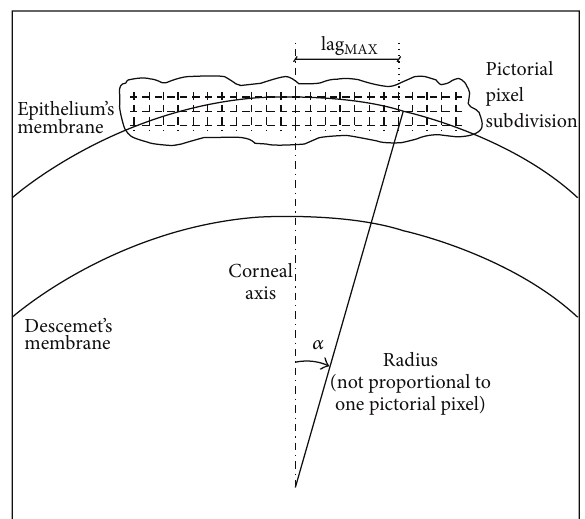
Figure 3: Pictorial representation of the procedure used to estimate the maximum number of columns on which the pixel intensity analysis is performed. In this sketch, the drawn Radius is not proportional to the pictorial pixel dimension.